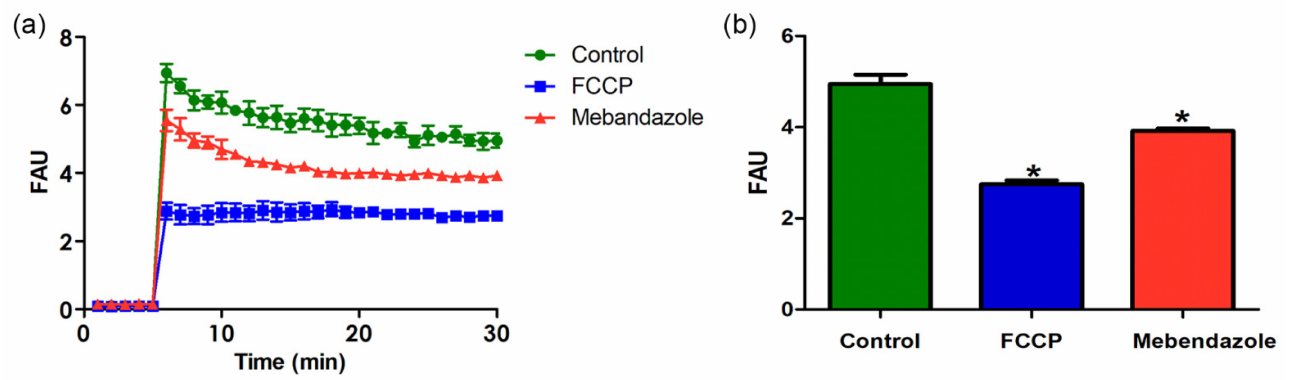
Figure 5. The ∆Ψ m analysis of control (with DMSO only) and H. capsulatum treated with mebendazole was performed using the JC-1 fluorochrome for 30 min. FCCP (1 µ M) was used as a positive control of the depolarization of the mitochondrial membrane. ( a ) Comparisons of the ∆Ψ m values between the different systems in different time points and ( b ) after 30 min of reaction. The results are expressed as fluorescence arbitrary units (FAU). Values represent the mean ± standard deviation of three independent experiments, performed in triplicate. The asterisk represents significant statistical differences (* p < 0.05) (Two-way